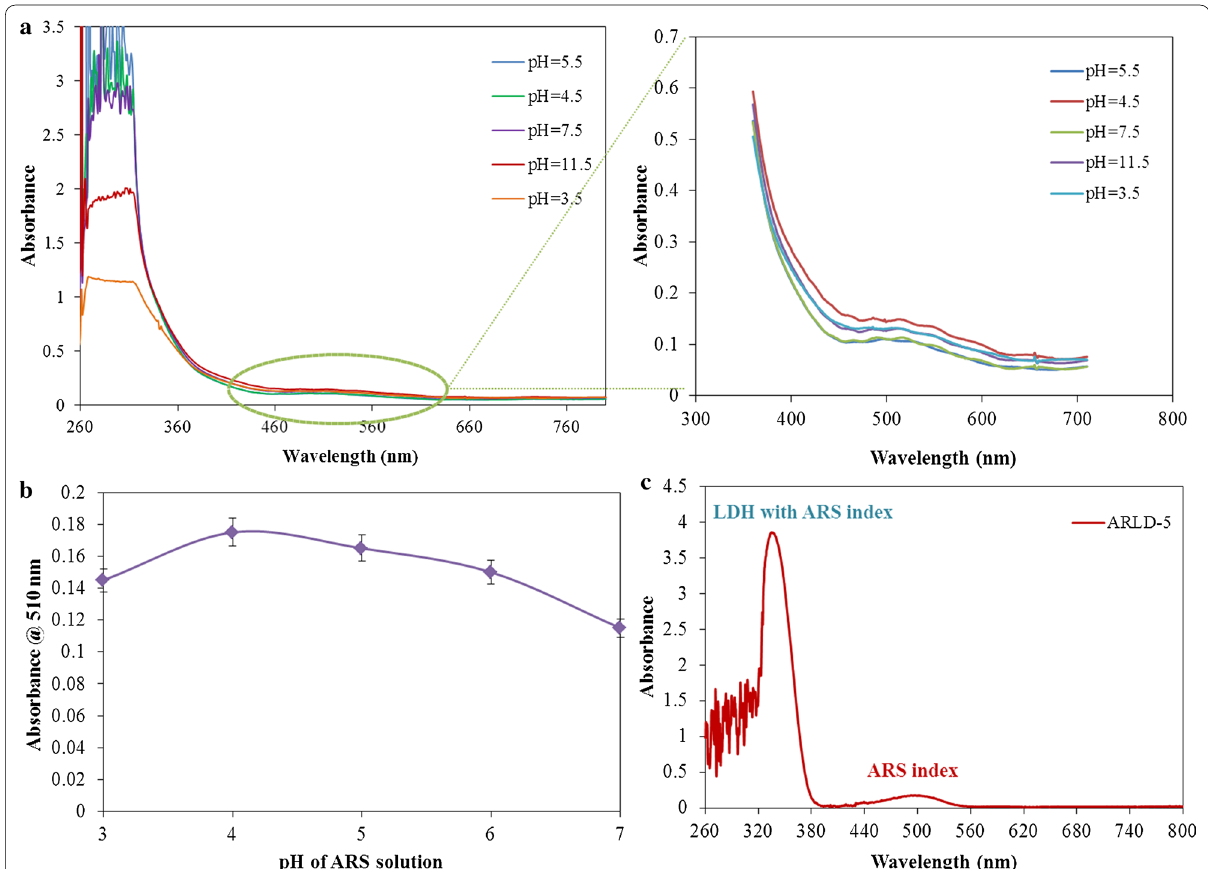
Fig. 1 Absorbance changes of ARLD-n against pH a LDH colloidal suspension (1.0 g L − 1 ) in deionized water in different adjusted pH (pH of ARS solution was fixed at 7 in LbL cycles), b ARS solution (1.0 g L − 1 ) in deionized water in different adjusted pH (pH of LDH suspension was fixed at 5.5 in LbL cycles), c absorbance changes of ARLD-5 (pH of LDH suspension was fixed at 5.5 and pH of ARS solution was fixed at 4.0 through LbL